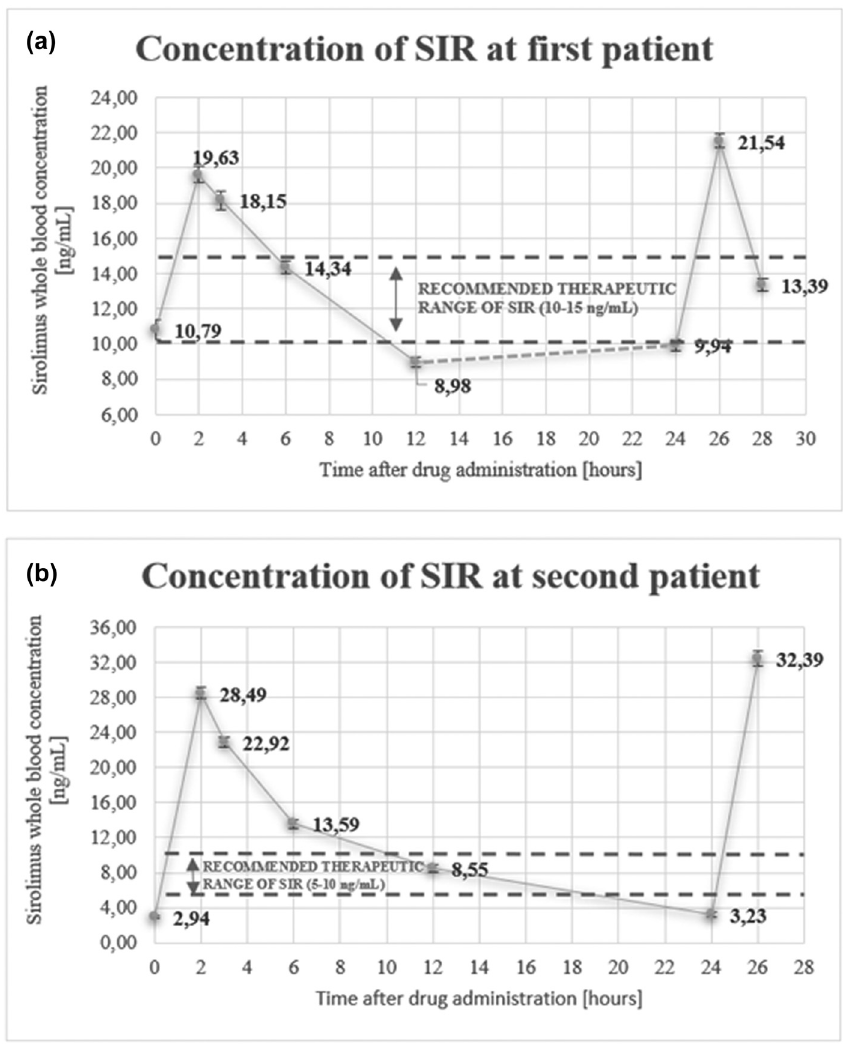
Figure 2: Sirolimus concentration in whole blood versus time pro fi le for ( a ) Patient 1 taking 1.9 mg of SIR once every 12 h and ( b ) Patient 2 taking 2.0 mg of SIR once every 24 h. The dashed line indicates the time period during which no samples were